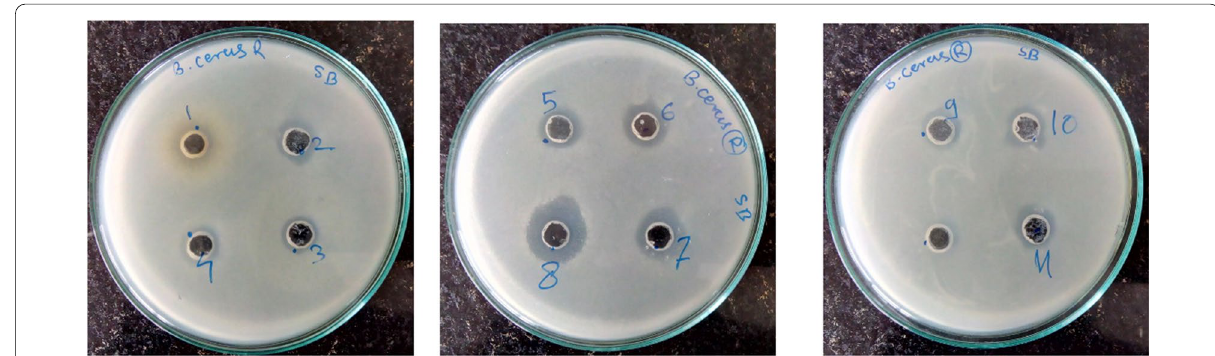
Fig. 3 Antimicrobial activity of dual gradient (pH and acetone) fractions (1–11) by agar well diffusion assay against B. cereus ATCC 10,876 (6 mm